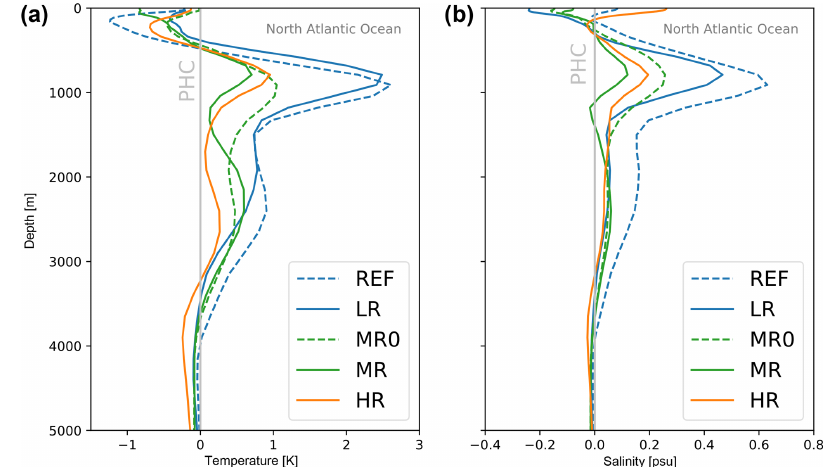
Figure 4. Profiles of potential temperature (a) and salinity (b) in the North Atlantic Ocean for years 71–100 of the pre-industrial simulations. Shown is the mean difference to PHC (PHC 3.0, updated from Steele et al., 2001). With the medium- and high-resolution meshes, the biases around 1000m depth decrease strongly for both temperature and